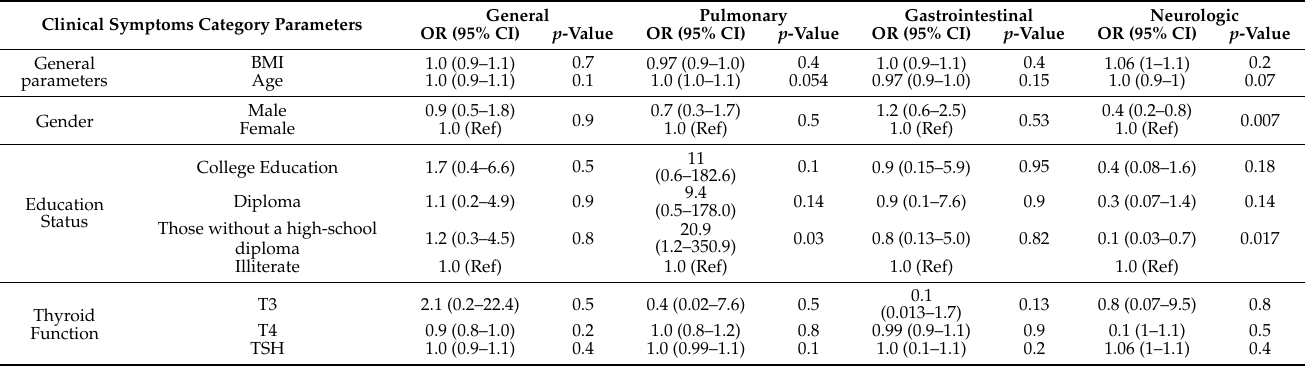
Table 2. Odds ratio and 95% confidence interval (95% CI) estimated by GEE analysis with AR (1) model to determine the progression of the clinical symptoms and the associations with demographic and laboratory parameters among infected patients